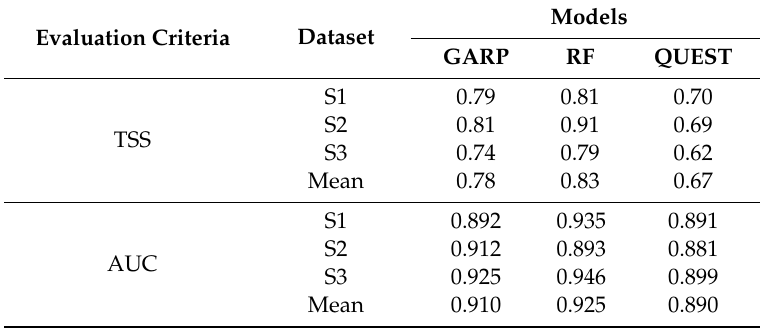
Table 5. Predictive performance of the machine learning models based on di ff erent performance evaluation metrics.